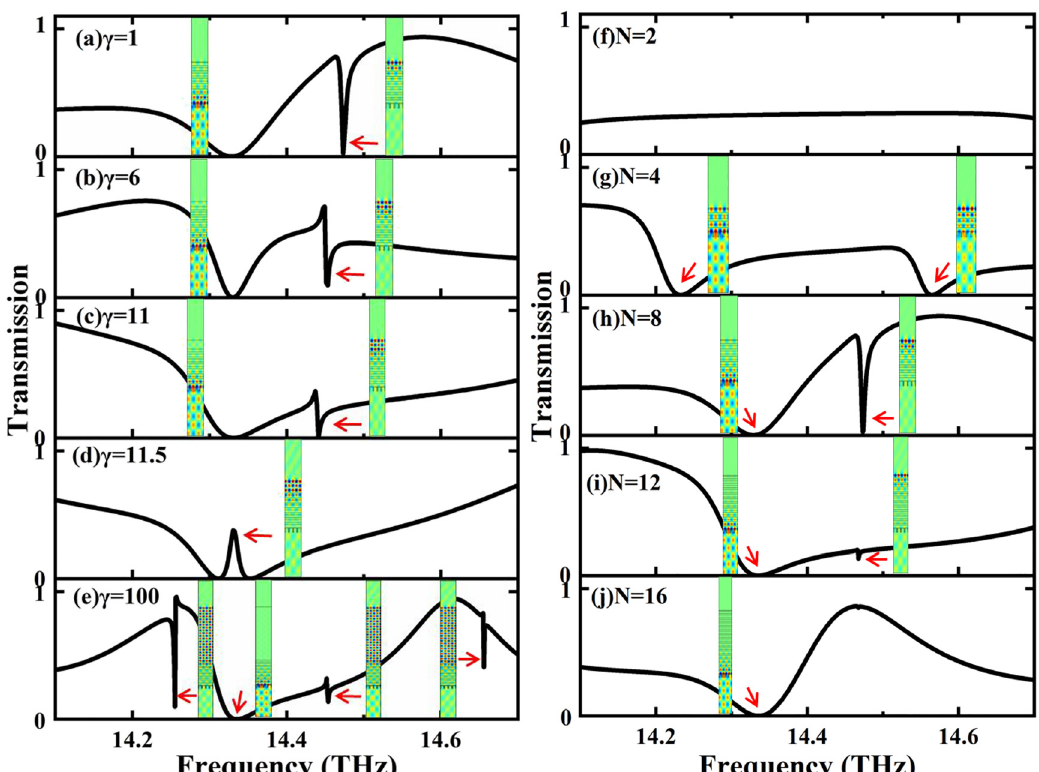
Figure 4: The transmissions response of different scenarios by adjusting the asymmetry factor (a) γ = 1, (b) γ = 6, (c) γ = 11, (d) γ = 11.5 and (e) γ = 100,note here N = 8 and t μ m. The transmissions responseof different scenariosby adjustingthe number of periodic layers (f) N = 2, grl = 2 (g) N =4, (h) N = 8,(i) N = 12and(j) N = 16, notehere γ = 1and t grl = 2 μ m.The distribution of theelectric fi eldin z directionis presentednextto the resonance